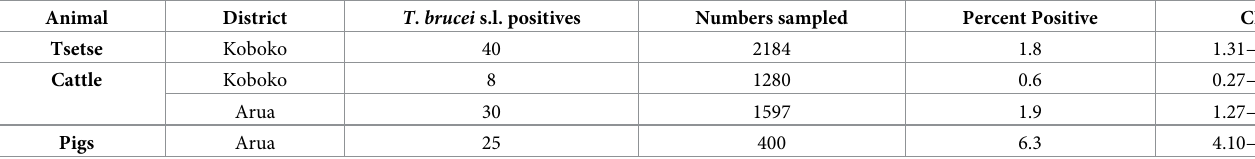
Table 4. The prevalence of PCR T . brucei s.l. positives across all samples and districts.